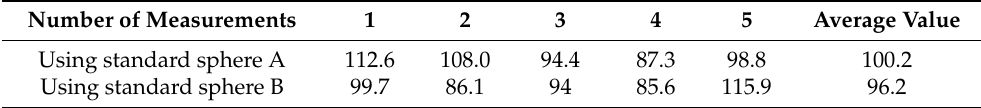
Figure 17. Comparison of different measurement objects. Table 3. Standard sphericity separation error (standard sphere B)